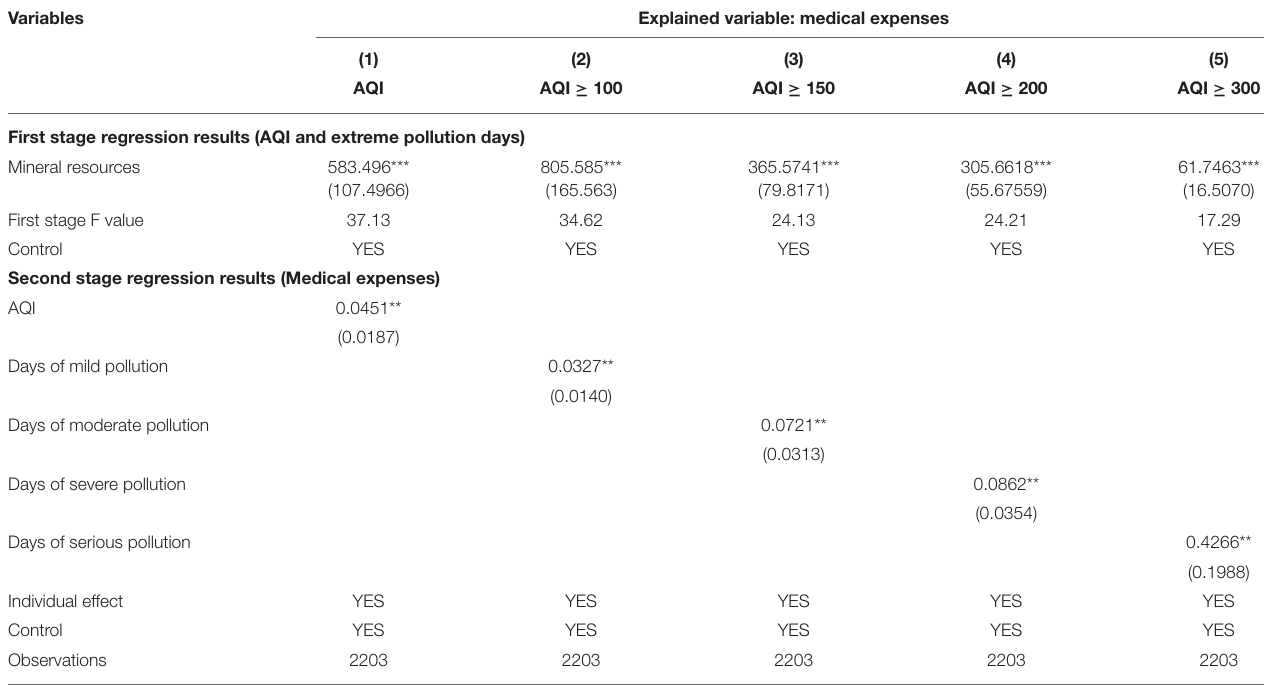
TABLE 4 | Instrumental variable treatment: air pollution and medical expenses. Variables